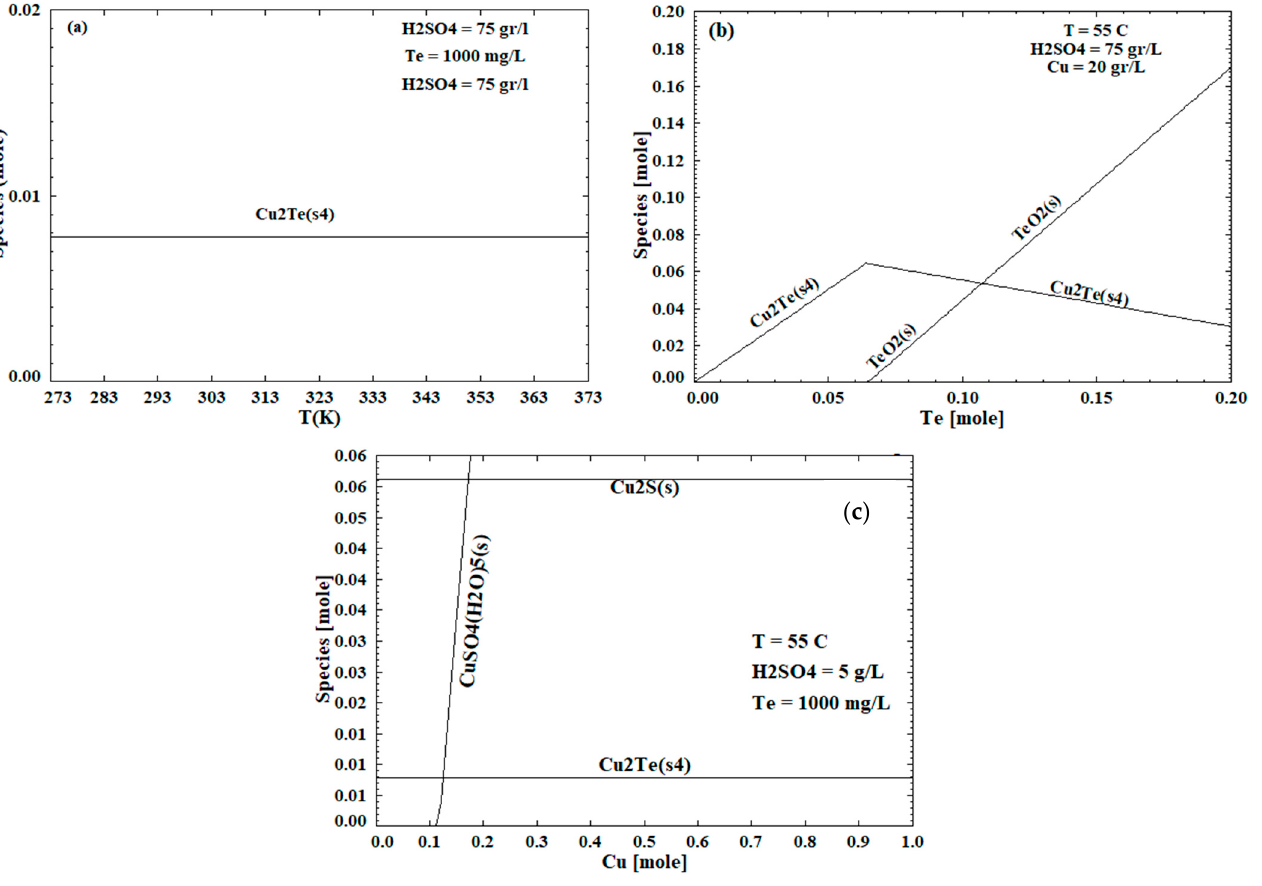
Figure 3. Te species in different amount of ( a ) H2SO4; ( b ) tellurium; ( c ) copper sulfate at mean quantity of other factors.